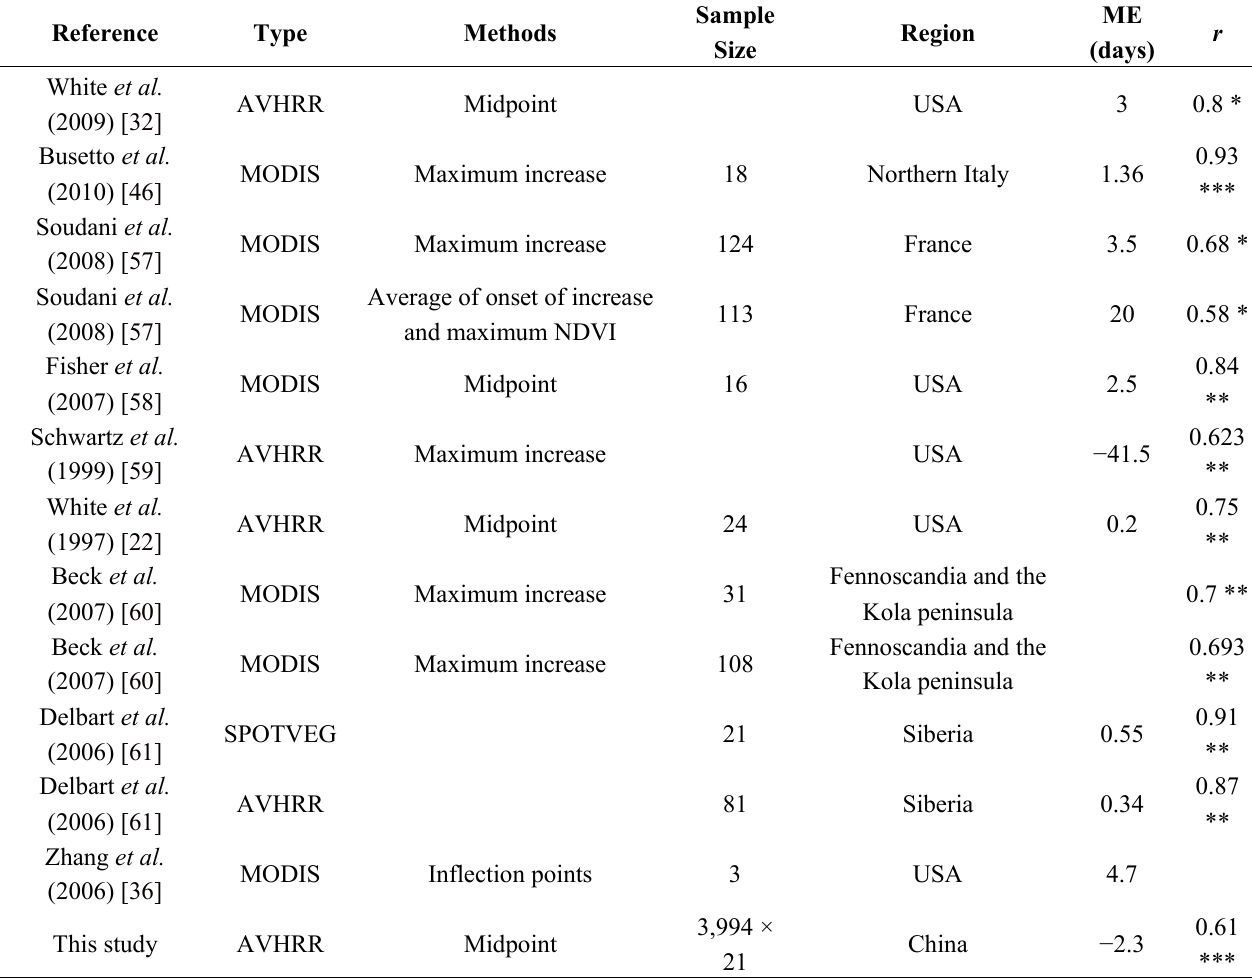
Table 2. Comparison in spatiotemporal validation of satellite-derived spring phenology based on different Vegetation Indices and conventional phenological data.